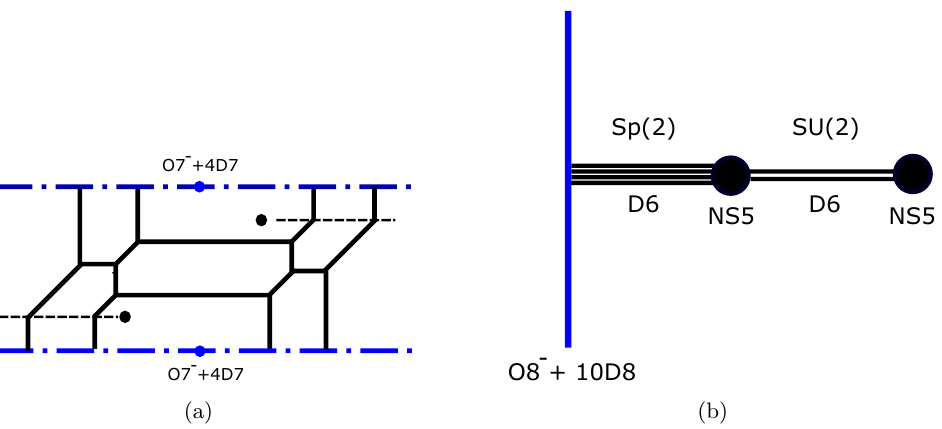
Figure 33 . (a) Another diagram for the SU(6) 0 aguage theory with N TAS = 1 ; N F = 10 with two O7 (cid:0) -planes. (b) A type IIA brane con(cid:12)guration after applying T-duality along the vertical direction in (cid:12)gure